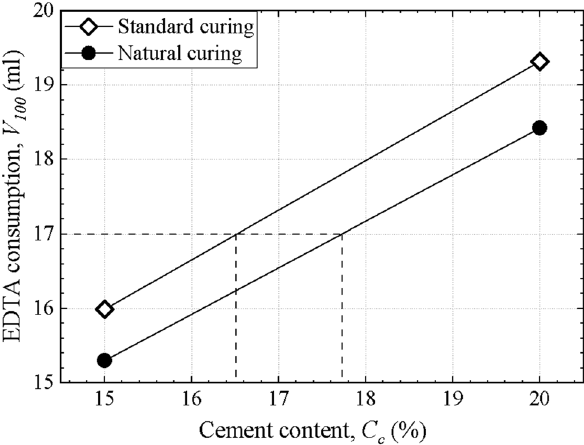
Figure 4. EDTA standard curves of different curing